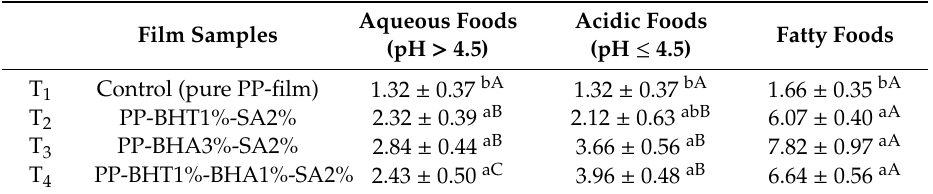
Table 2. The results of overall migration (mg / dm 2 ) in di ff erent food